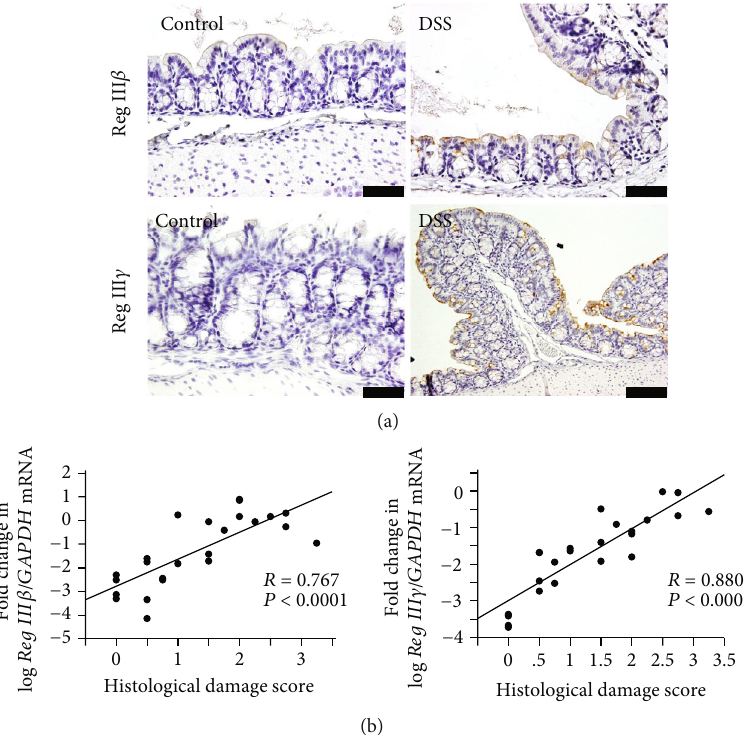
Figure 3: Expression of Reg III β / γ and its correlation with histological damage score in colonic tissue with DSS-induced colitis. (a) Immunostaining of Reg III β / γ in the colonic mucosa of mice with DSS-induced colitis and in controls. Bars indicating 50 μ m. (b) Correlation between expression of Reg III β / γ mRNA and histological damage scores in colonic tissue. Results are expressed as the mean ± SE